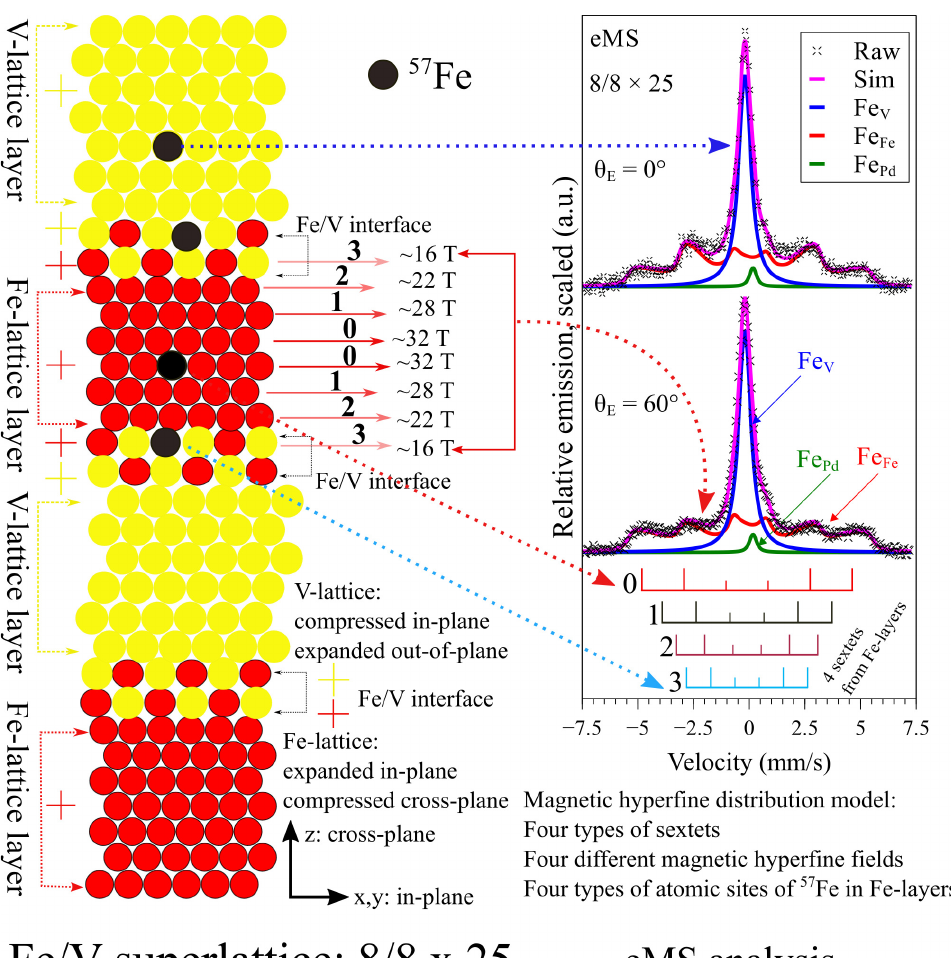
Figure 7. Schematic showing that the distribution of magnetic hyperfine field is related to the local lat- tice environments of the 57 Fe + probe atoms in the Fe/V superlattice structure, with 8/8 × 25 sample as an example, which contains 25 periods of evenly spaced 8/8 Fe/V